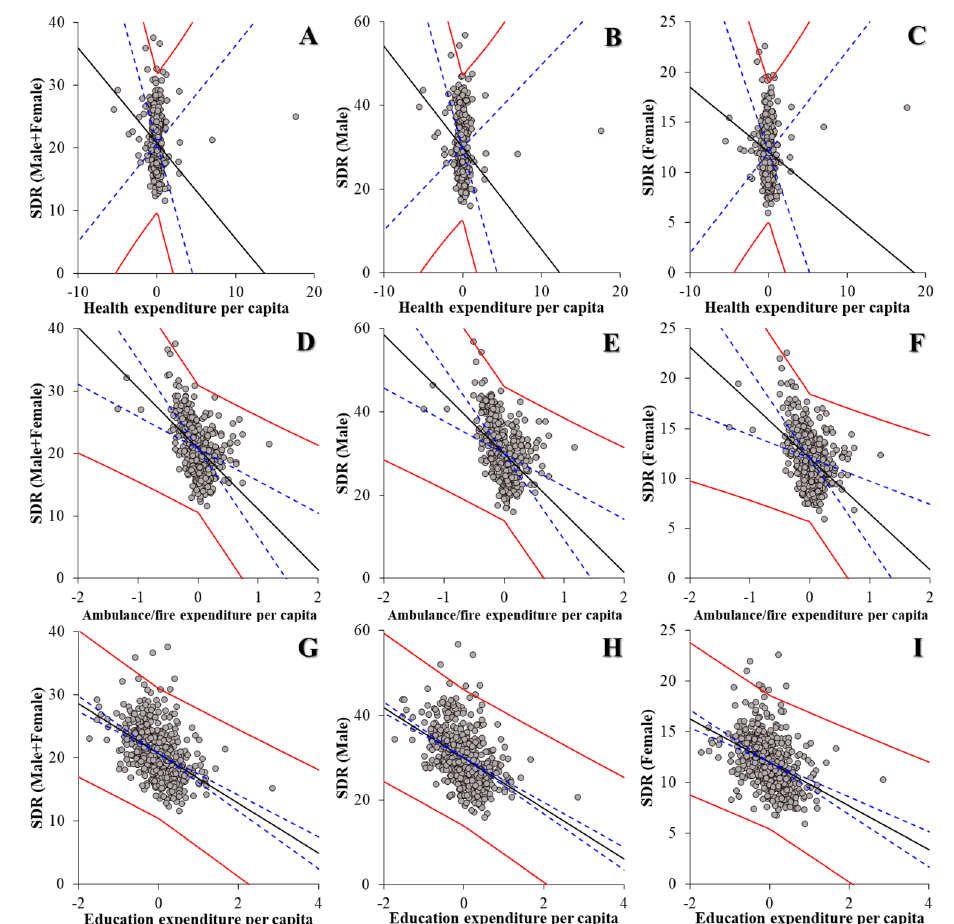
Figure 4. Effects of financial expenditure per capita of public health ( A – C ), ambulance and fire services ( D – F ), and education ( G – I ) of prefectures and municipalities on regional suicide mortality of males and females together ( A , D , G ), males ( B , E , H ), and females ( C , F , I ) from 2009 to 2018 using fixed- or random-effect analysis of hierarchal linear regression with robust standard error. Ordinates and abscissas, SDR of suicide mortalities (per 100,000 population) and centralised expenditure per capita of prefectures plus municipalities (JPY 10,000), respectively. Black, blue, and red lines, slope of fixed effects, standard deviation of fixed effects, and fixed effects with random effects, respectively.